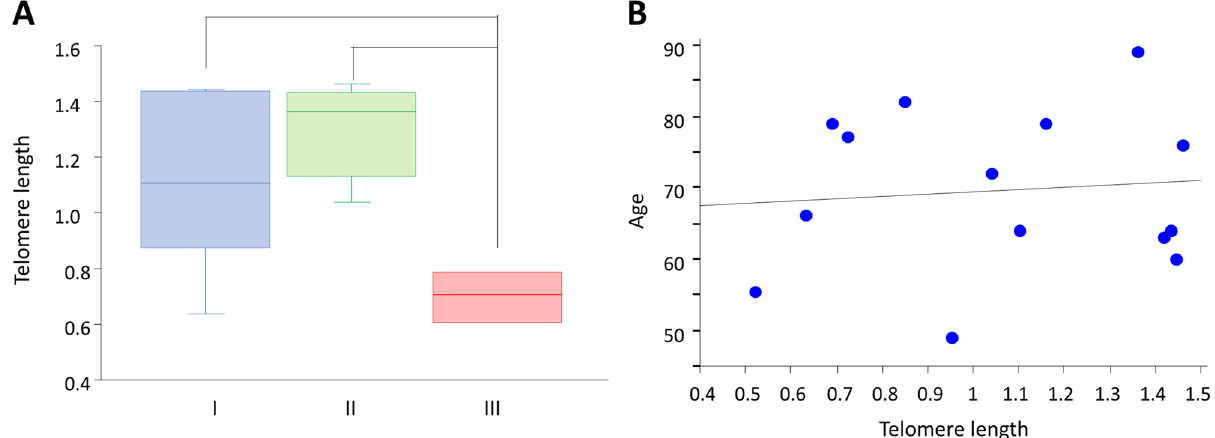
Figure 2. Telomere length was correlated to grade. ( A ) Telomere length and WHO grade. Tukey–Kramer test. ( B ) Telomere length and age. WHO World Health